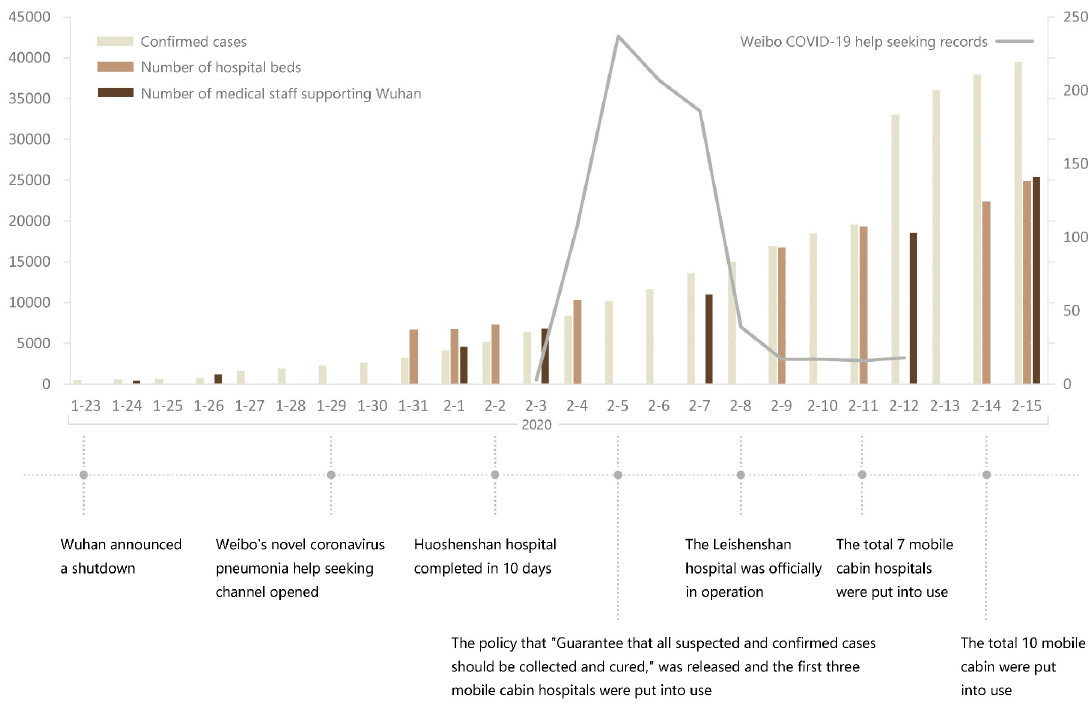
Figure 1. Time-series change histogram in the early stage of the epidemic.